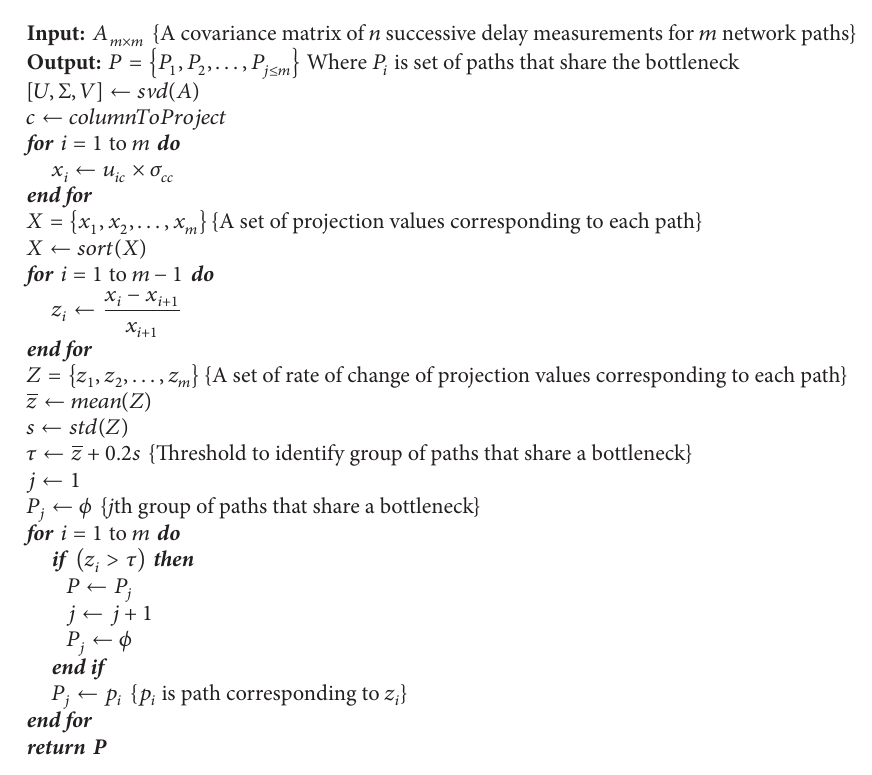
Algorithm 1: Detection of paths that share a